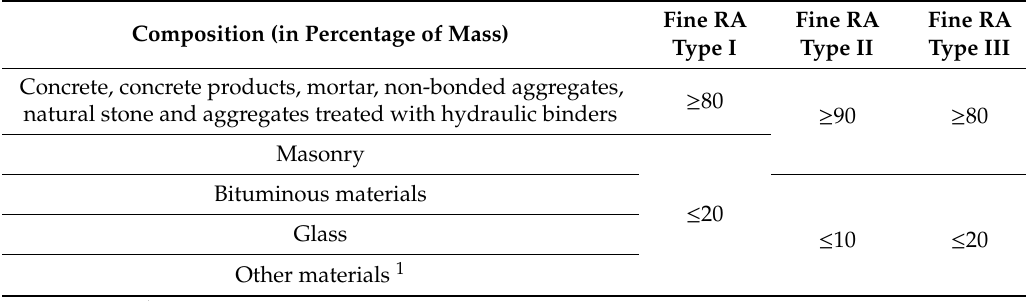
Table 3. Composition of the three types of fine